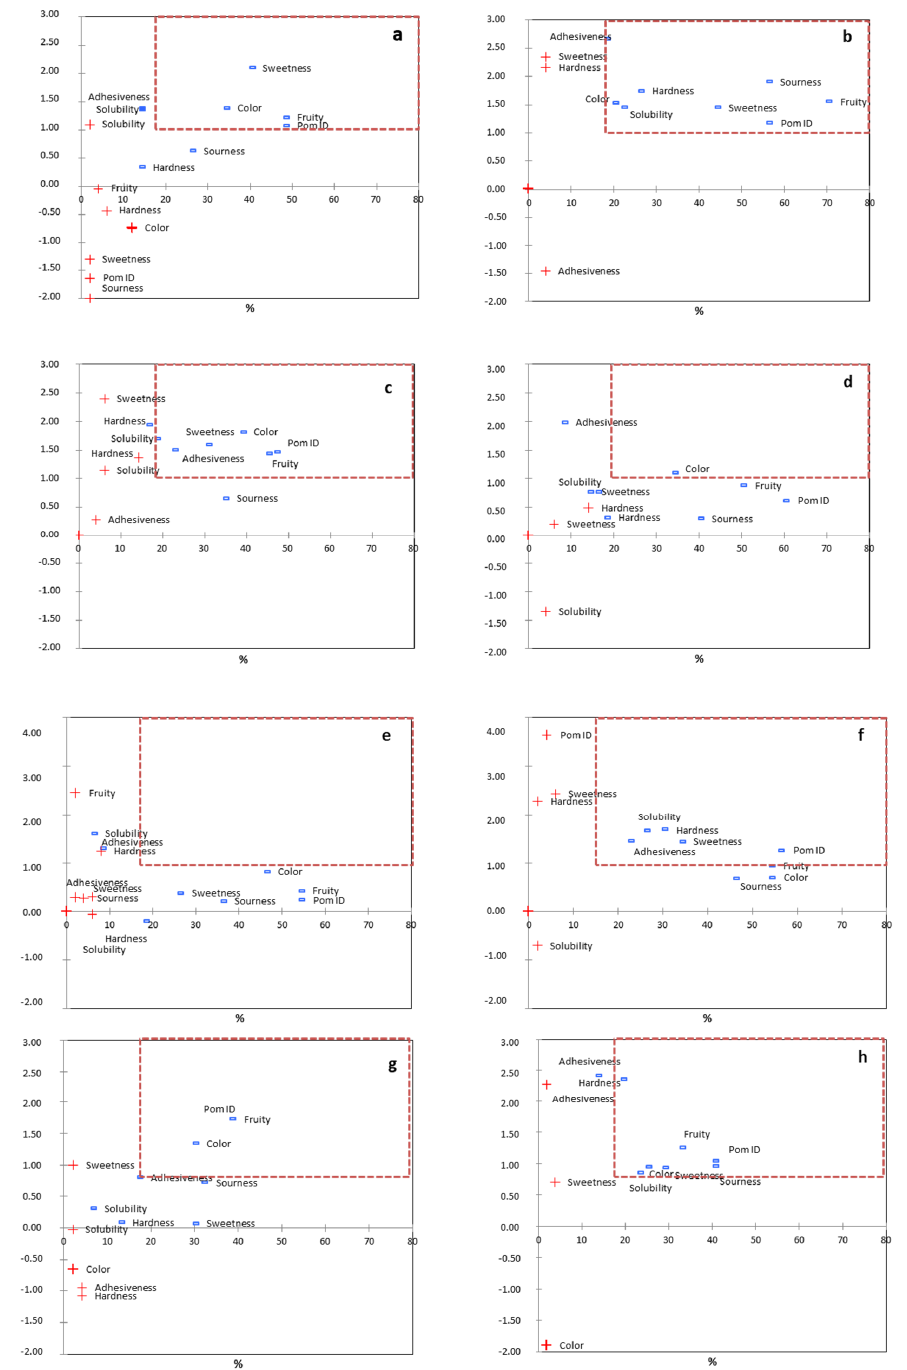
Figure 2. Penalty analysis of samples (sample code indicated on the top left of each figure; “too low intensity” indicated with “—”, and “too high intensity” indicated with “ + ”); ( a ) indicated PJAPH-20c + inf; ( b ) indicated PJAPH-20c; ( c ) indicated PJAPHS-20c + inf; ( d ) indicated PJAPHS-20c; ( e ) indicated PJH-20c + inf; ( f )indicated PJH-20c; ( g ) indicated PJS-20c + inf; ( h ) indicated